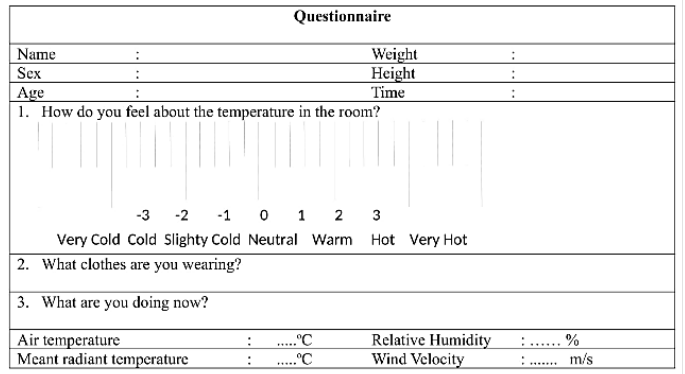
Figure 1. Questionnaire. Figure 1.